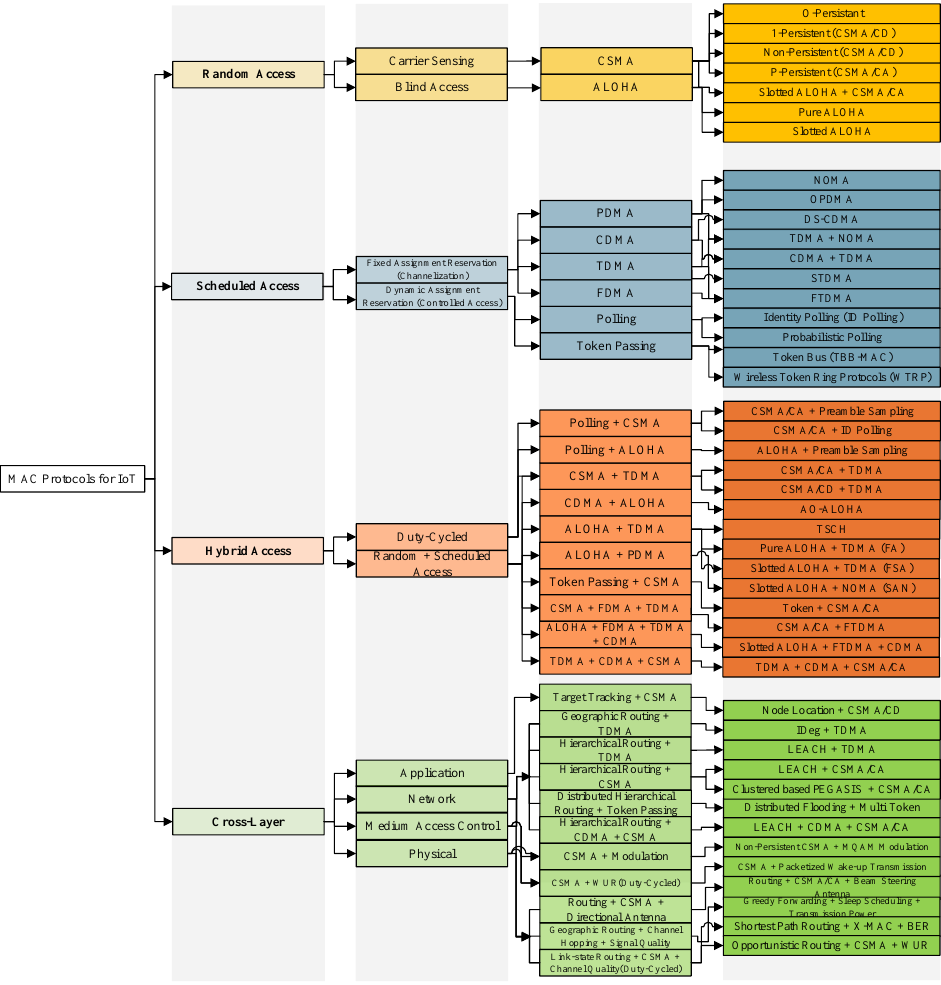
Figure 3. IoT systems Medium Access Control